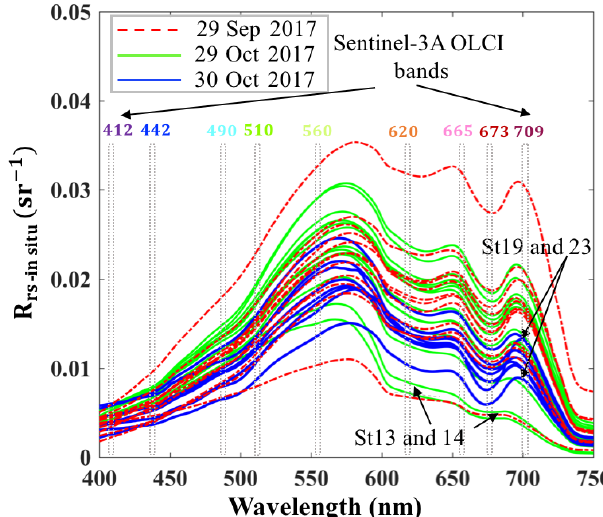
Figure 3. R rs_insitu spectra at stations in GB on 29 September and 29–30 October 2017; vertical bars represent Sentinel-3A OLCI spectral